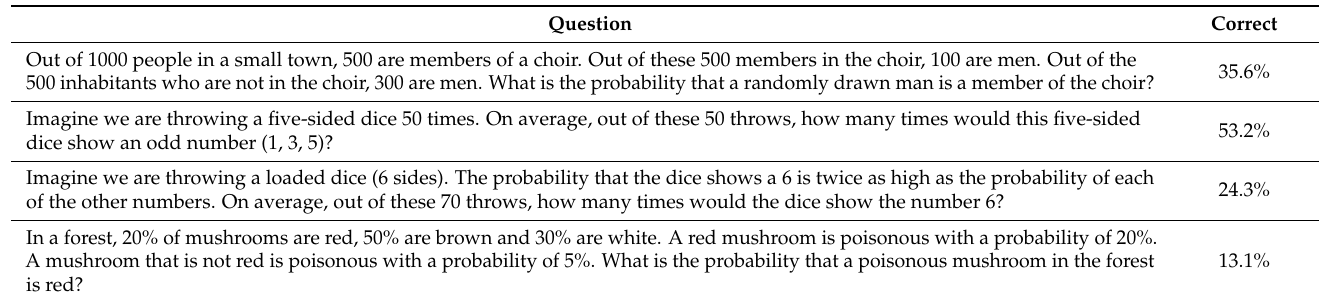
Table A3. Berlin Numeracy Test questions.